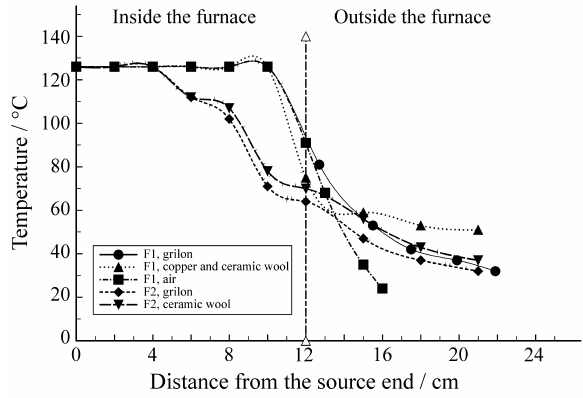
Figure 1. Temperature profiles determined for F1 and F2 furnace con- figurations with different type of insulator.